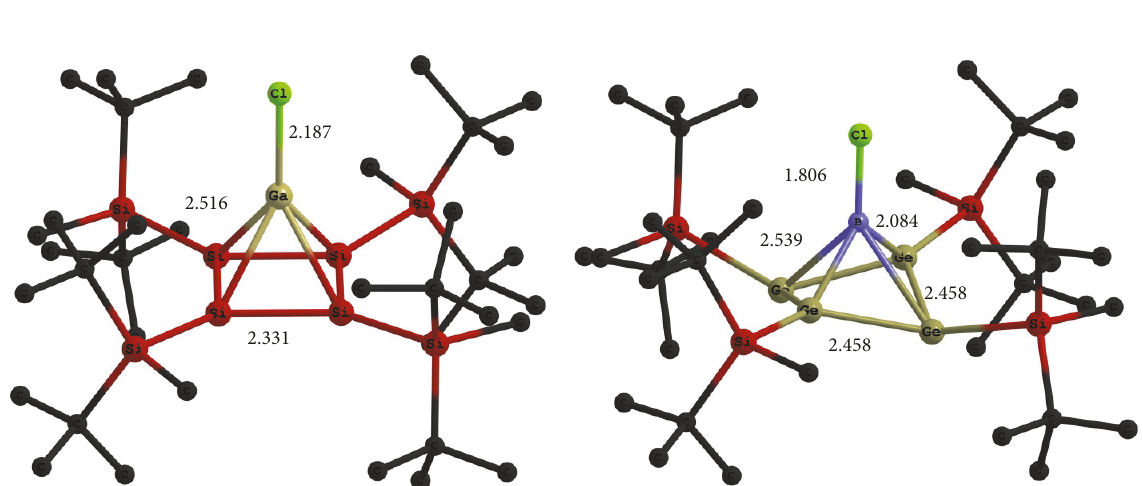
Figure 1): 102.7 ∘ for R = H, 99.3 ∘ for R = SiH 3 , and 97.9 ∘ for R = SiMe 3